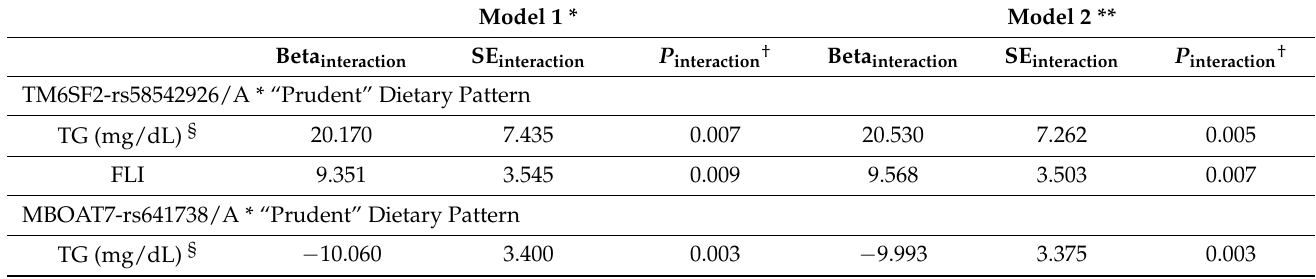
Table 3. Significant interactions of adherence to the “Prudent” dietary pattern with genetic variants.